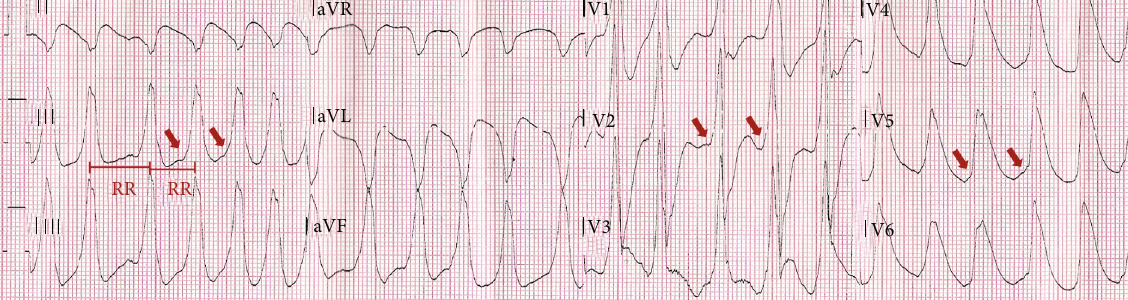
Figure 2: Twelve-lead electrocardiogram showing atrial fi brillation with a rapid preexcited ventricular response. Irregular RR intervals, wide QRS complexes with varying QRS width, and initial delta wave (arrow). The shortest preexcited RR interval is nearly